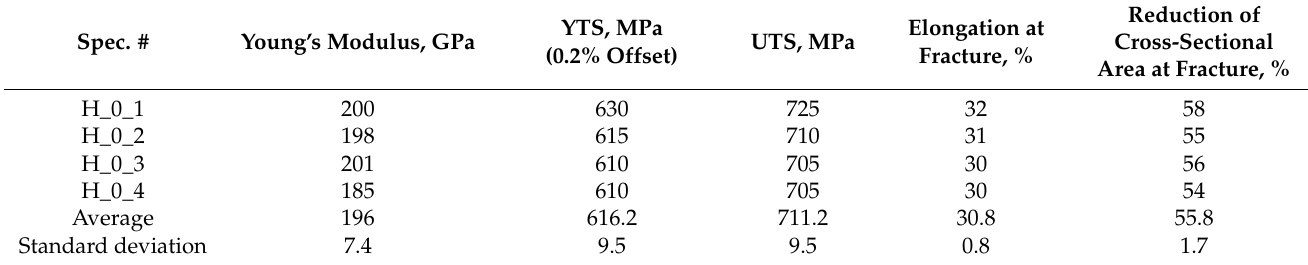
Table 3. The measured mechanical properties of “H_0”